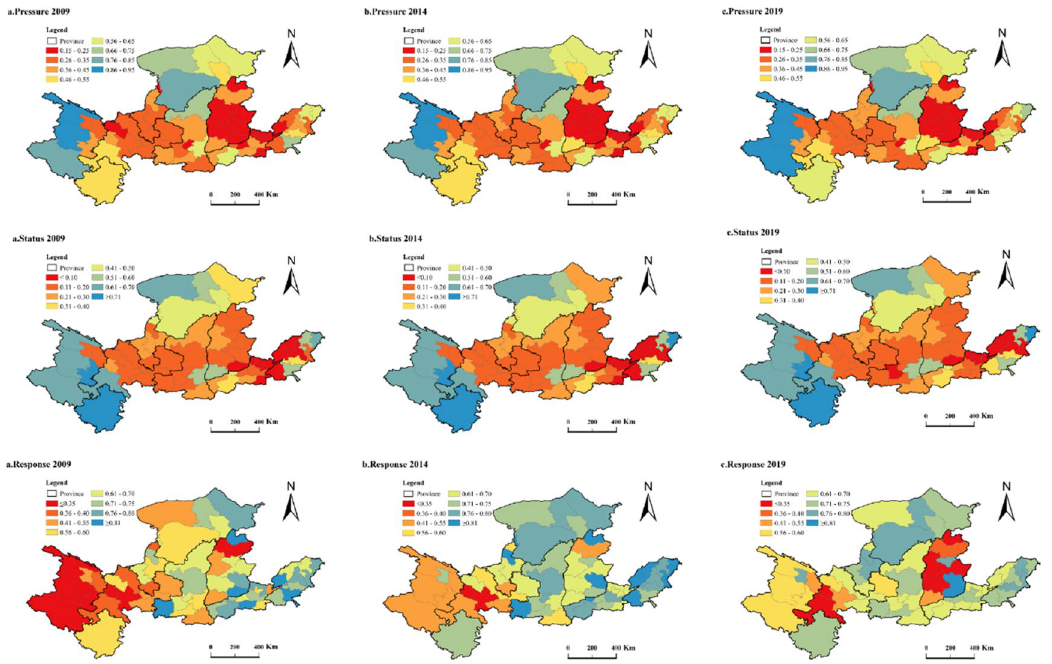
Figure 4. Quantitative spatial distribution map of the 62 cities in the Yellow River Basin. Note This was created by ArcMap-GIS, version 10.5. https:// www. esri.